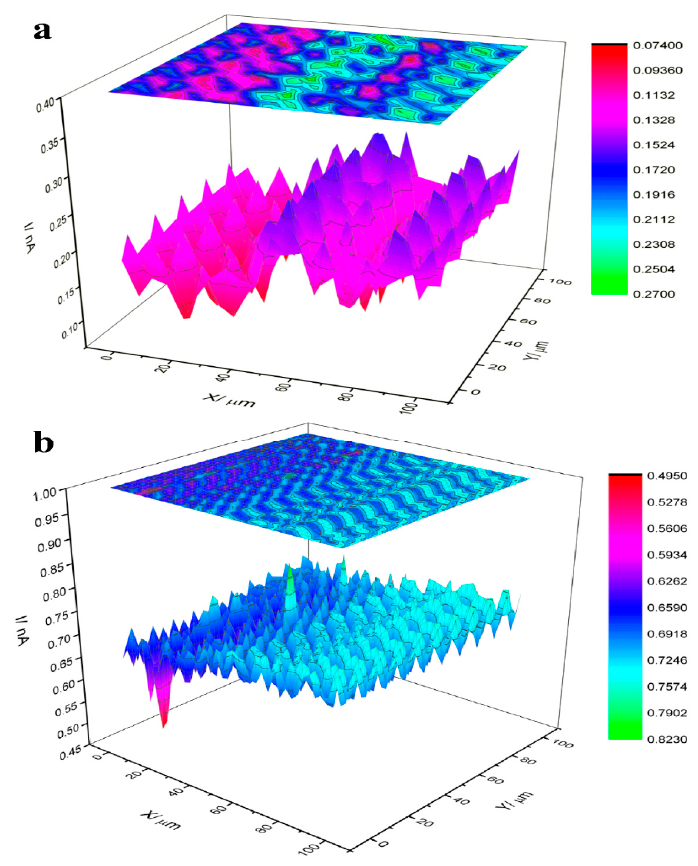
Figure 3. ( a ) Scanning electrochemical microscopy (SECM) image of glassy carbon electrode covered with Nafion. ( b ) SECM image of glassy carbon immobilized with QDs and covered with Nafion. The applied parameters: the tip electrode scan rate: 20 µm/s, the applied potential on tip: 0.5 V, the tip— substrate distance: 10 µm, quiet time: 30 s, the scanned surface area 100 µm × 100 µm.